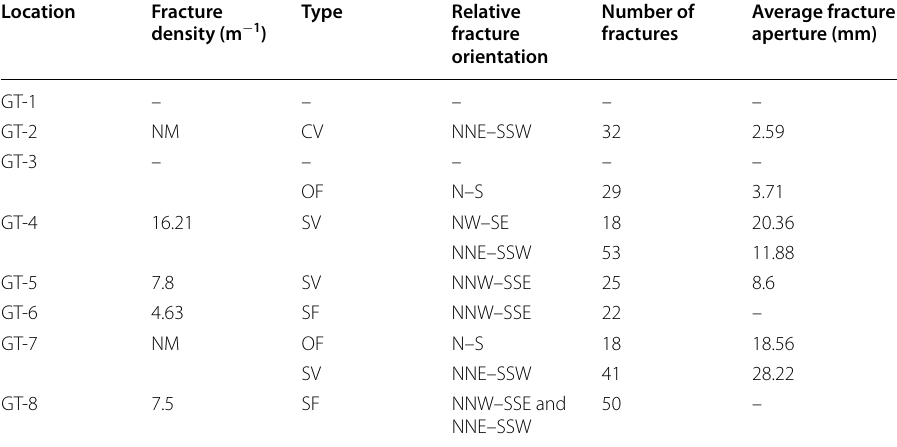
GT ground-truthing location, CV carbonate vein, OF open fracture, SV silica vein